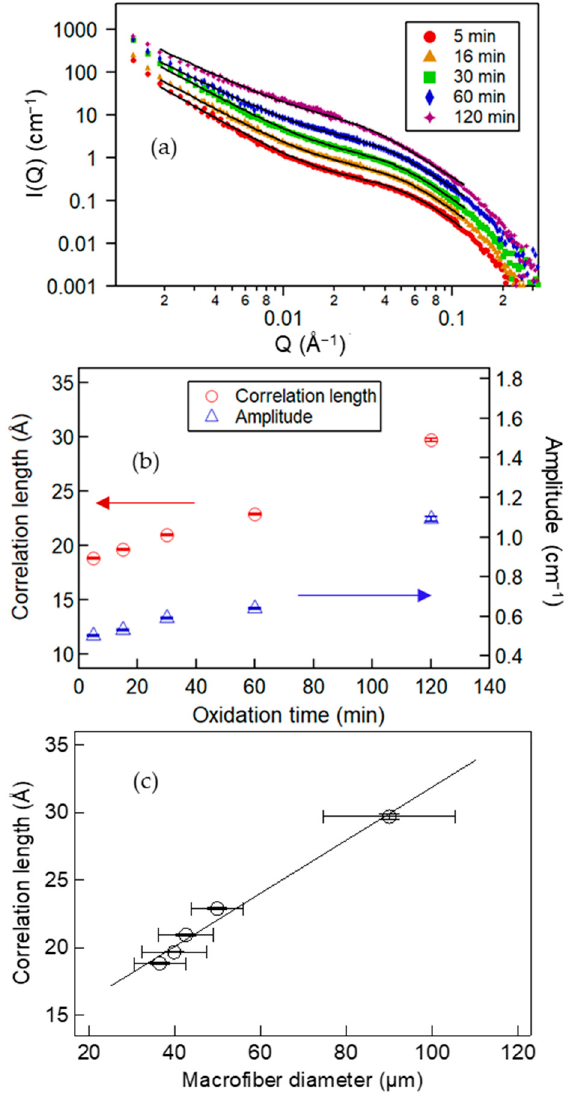
Figure 2. ( a ) Small-angle neutron scattering of macrofibers in aqueous suspension after various times of TEMPO-assisted oxidation. The symbols are experimental data and solid curves through the symbols are best-model fitting. Curves are vertically shifted for better visibility. ( b ) The correlation length and the amplitude of Lorentzian function as a function of the oxidation time. Both quantities increase with time. ( c ) The correlation length as a function of the mean diameter of macrofibers as in Figure 1f. The line through the symbols illustrates the linear relationship between the two quantities.